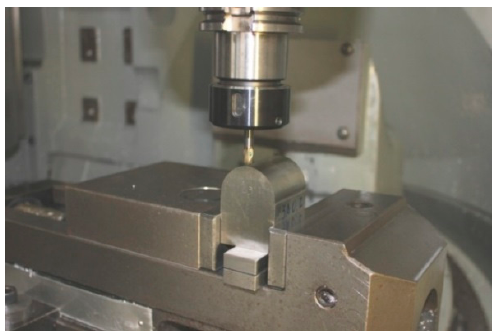
Figure 1. Manufactured part and high-speed machining center employed.